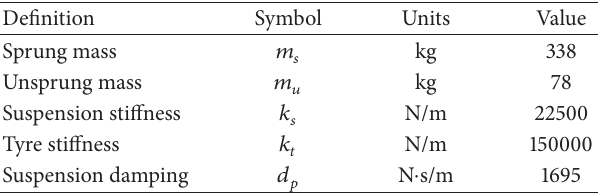
Table 3: Parameters of IWM-EV active suspension.